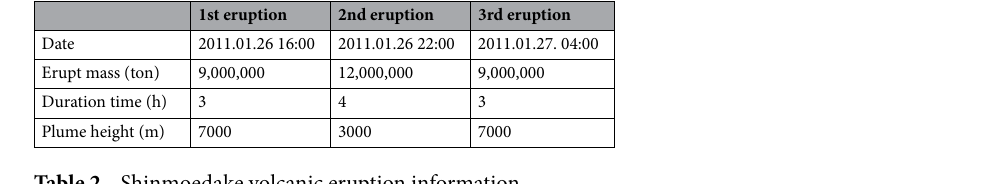
Table 2. Shinmoedake volcanic eruption